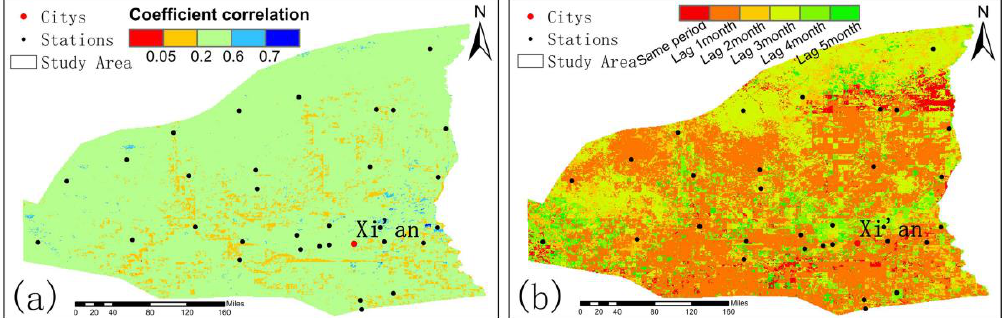
Figure 5. Spatial distribution of maximum cross-correlation ( a ) between NDVI and humidity index and time-lag response ( b ) in the Weihe region.